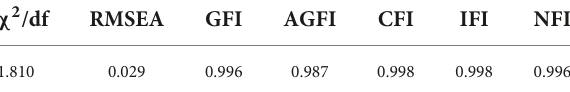
TABLE 4 Fitness index of structural equation model of achievement motivation.